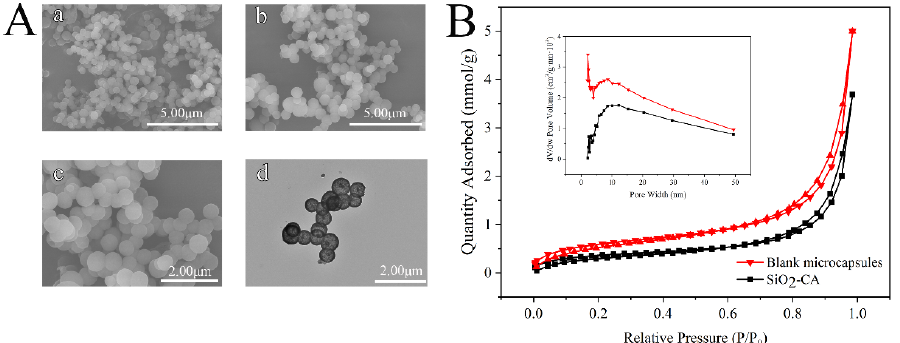
Figure 5. ( A ): Field-Emission Scanning Electron Microscope (FE-SEM) and transmission electron microscopy (TEM) images of silica microcapsules, (a), Blank microcapsules × 10 K, (b), SiO 2 -CA ×10 K, (c), SiO 2 -CA×20 K, (d), TEM image of SiO 2 -CA; ( B ): Nitrogen adsorption-desorption isotherm of microcapsules (within Pore size distribution of microcapsules).